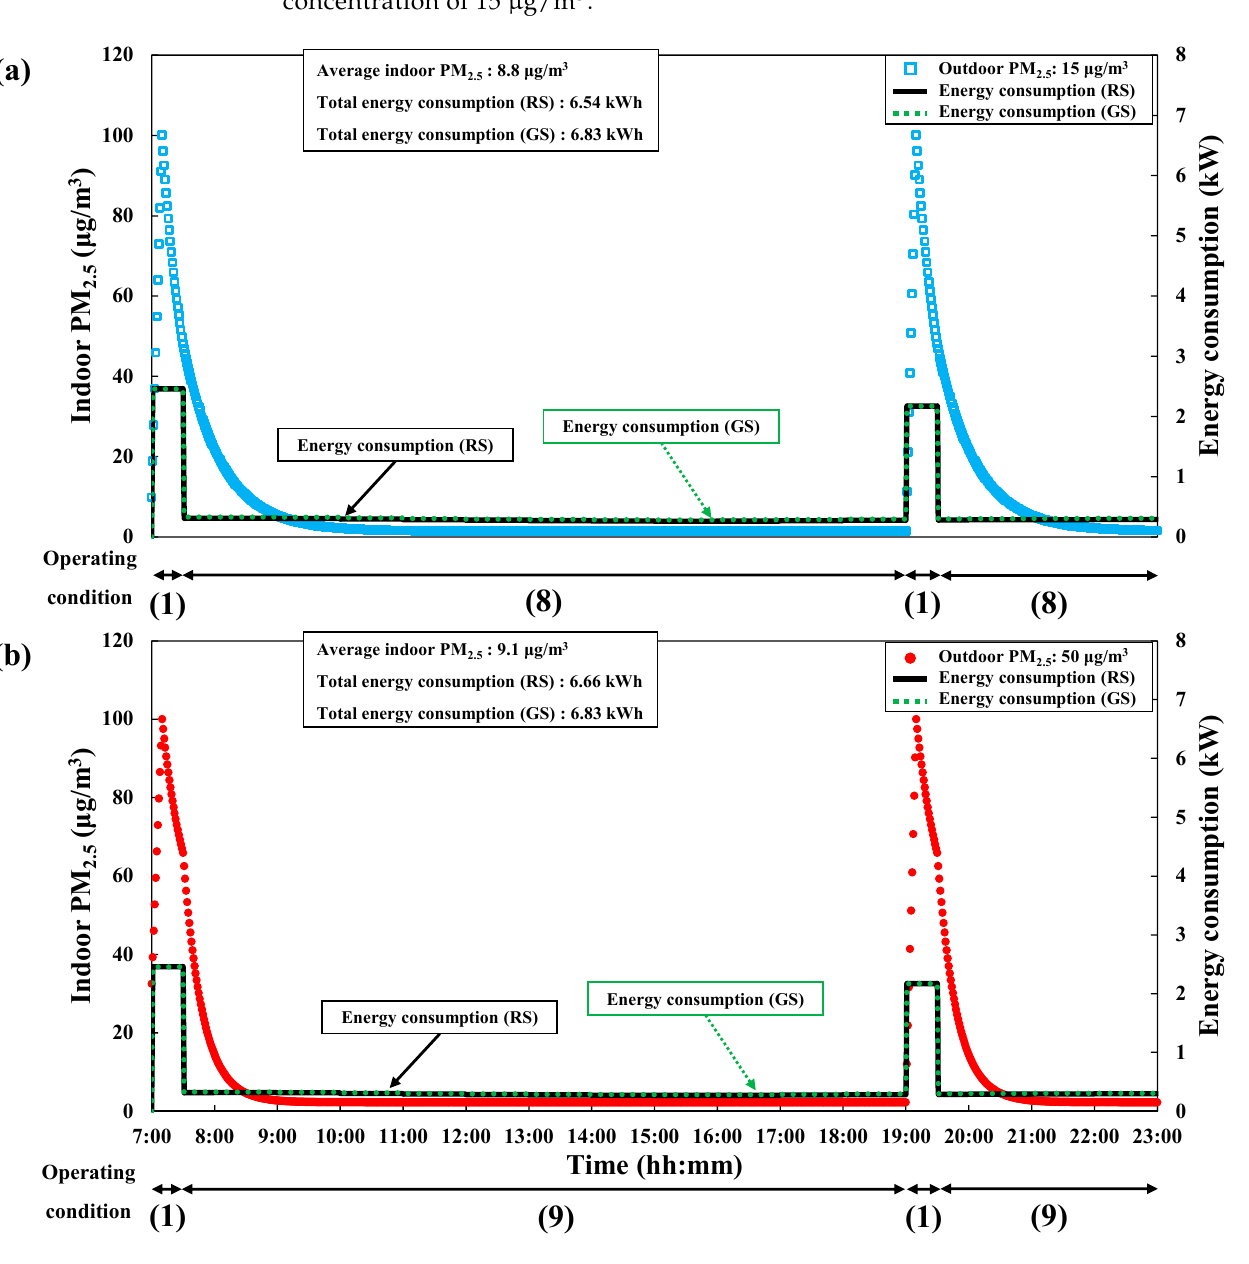
Figure 7. Changes in PM 2.5 concentration and energy consumption with time to maintain average PM 2.5 <10 μ g/m 3 under the energy consumption reduction scenario in winter (GS: general scenario, RS: reduction scenario). ( a ) Outdoor PM 2.5 : 15 μ g/m 3 . ( b ) Outdoor PM 2.5 : 50 μ g/m 3 .